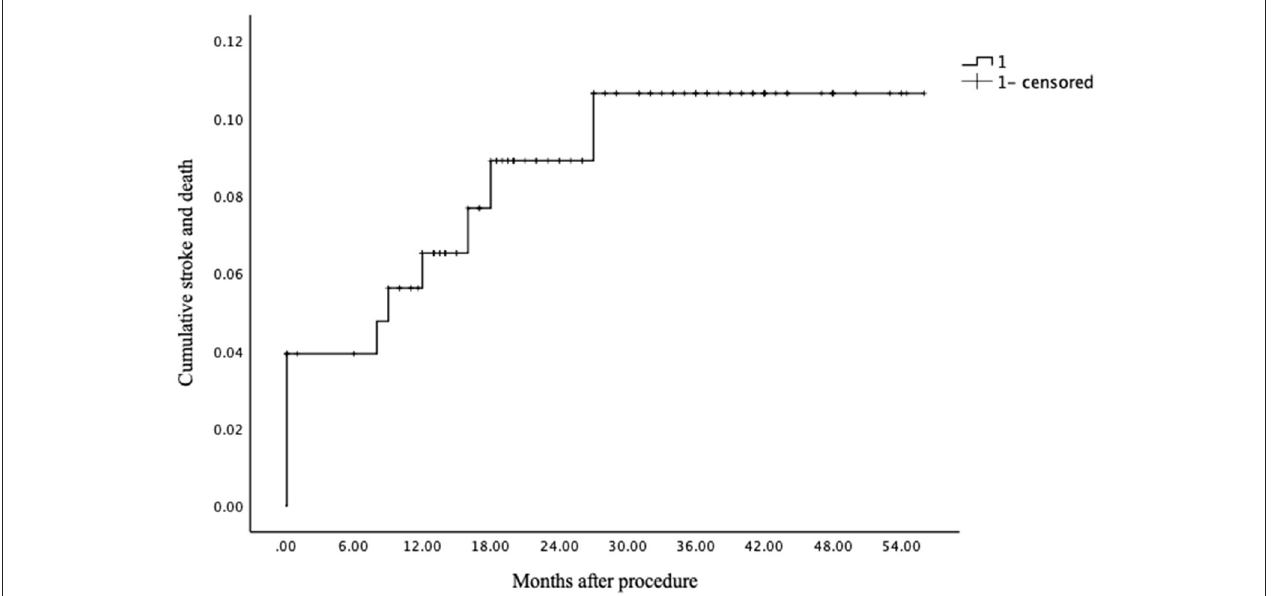
FIGURE 4 | Kaplan-Meier curve of cumulative stroke and death rate of the included patients in the present study.